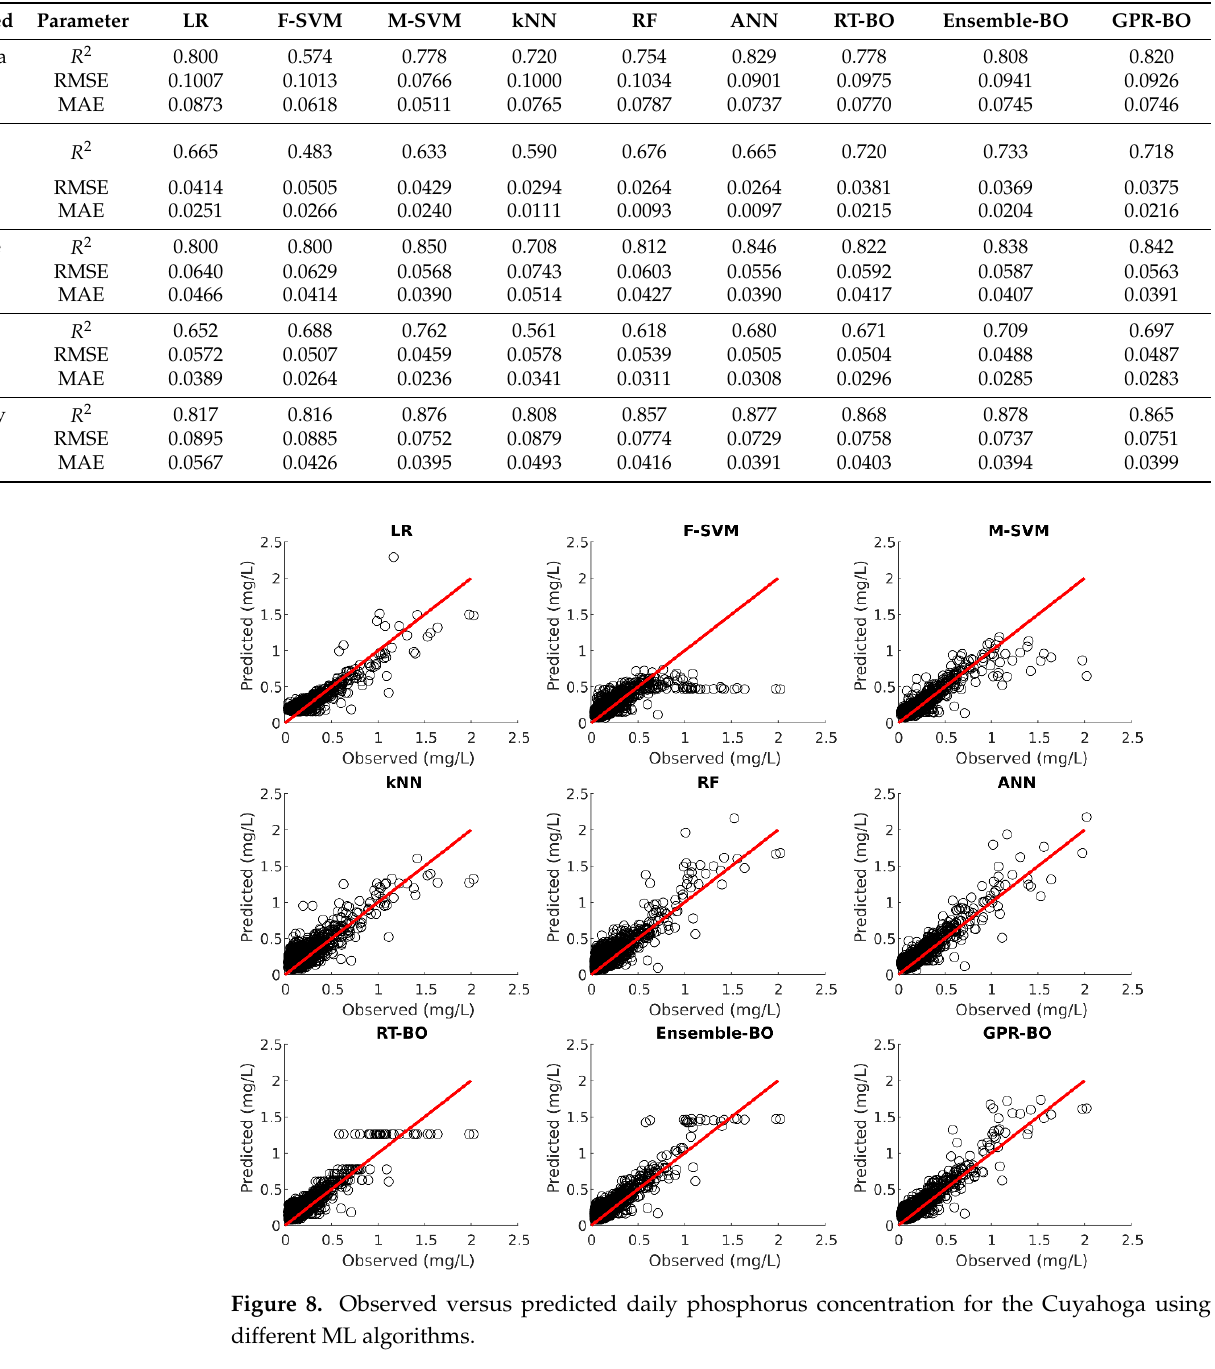
Figure 9. Observed versus predicted daily phosphorus concentration for the Grand using different ML algorithms.